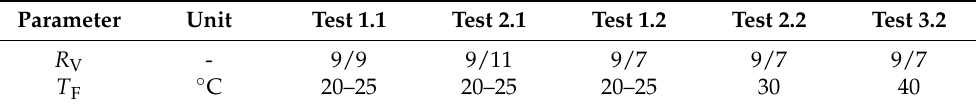
Table 13. Conditions for Series 1 and Series 2 tests. Symbols: R V —volumetric flow rate ratio (feed/RO permeate), T F —temperature of the inlet feed.